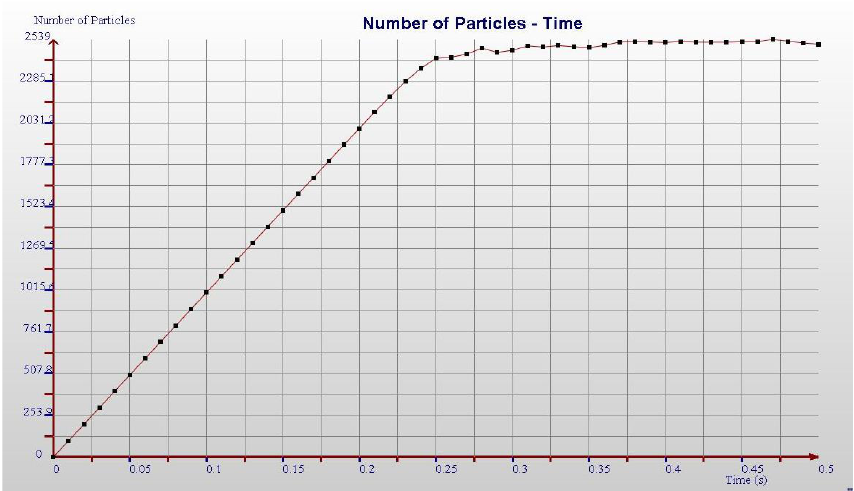
Figure 5. Time - Particle Number Diagram Figure 5. Time—Particle Number Diagram. Figure 5. Time—Particle Number Diagram.